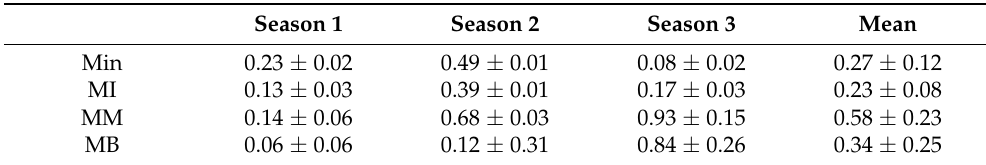
Table 3. N 2 O Emission Factor which is a percentage of fertilizer applied released as N 2 O emission (IPCC, 2006) for different fertilizer treatments and management depicting small scale farming systems in Central